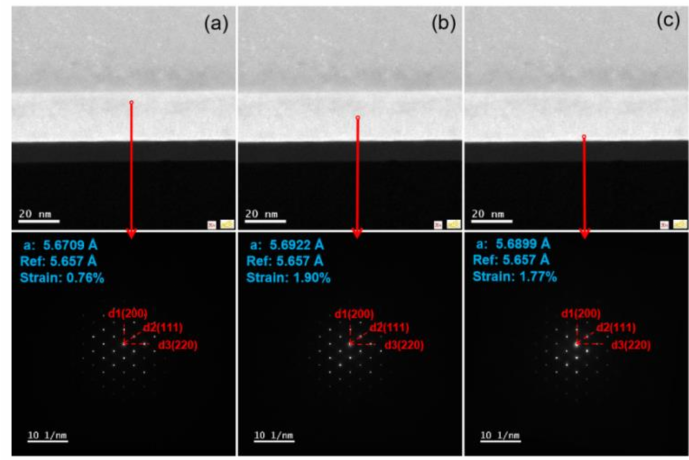
Figure 11. NBD in different GeSn regions of sample wet etched for 20 s; the reference is bulk Ge with lattice constant 5.657 Å. ( a ) Up; ( b ) middle; ( c ) down. Table 5. NBD results about GeSnOI strain before etching, and after wet etching for 20 s and 120 s. Sample Bulk Strain Strain ⊥ (002) Strain // (220) GeSnOI 2.79% 2.11% 0.47% 20 s 1.90% 1.60 % 0.17 % 120 s 1.19% 2.24% −